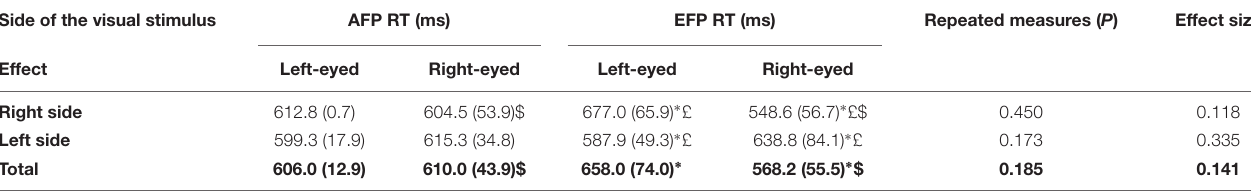
TABLE 4 | Athletes’ performance on agility test: reaction times. Side of the visual stimulus AFP RT (ms) EFP RT (ms)